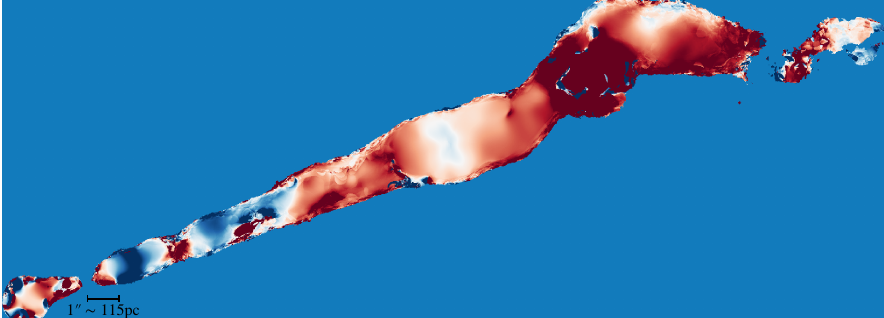
500 to 500 rad/m 2 . Variations on the RM −